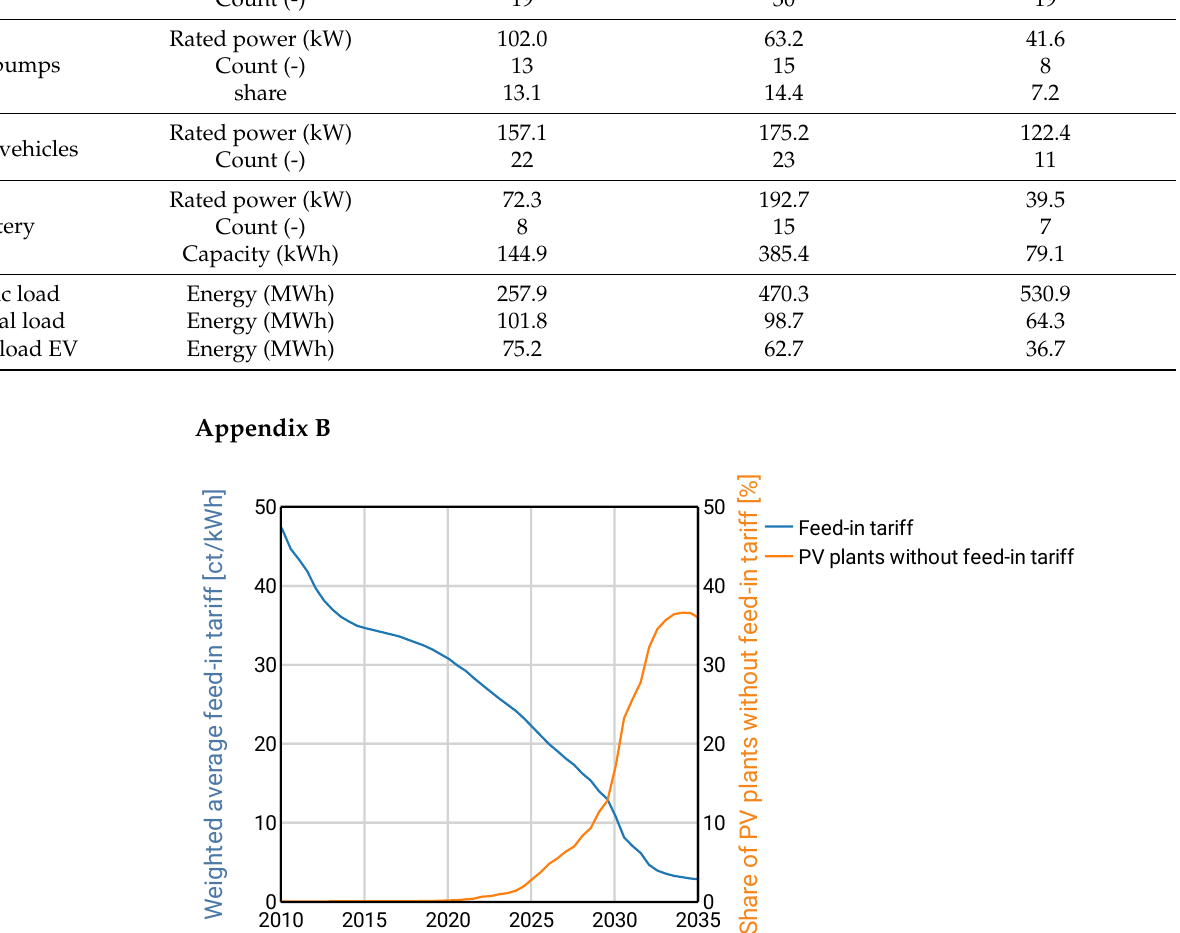
Figure A1. Development of weighted average feed-in tariffs for PV power plants and share of PV plants without feed-in tariffs in Germany. Data based on [33], extrapolated for years after 2021 using [25,39].